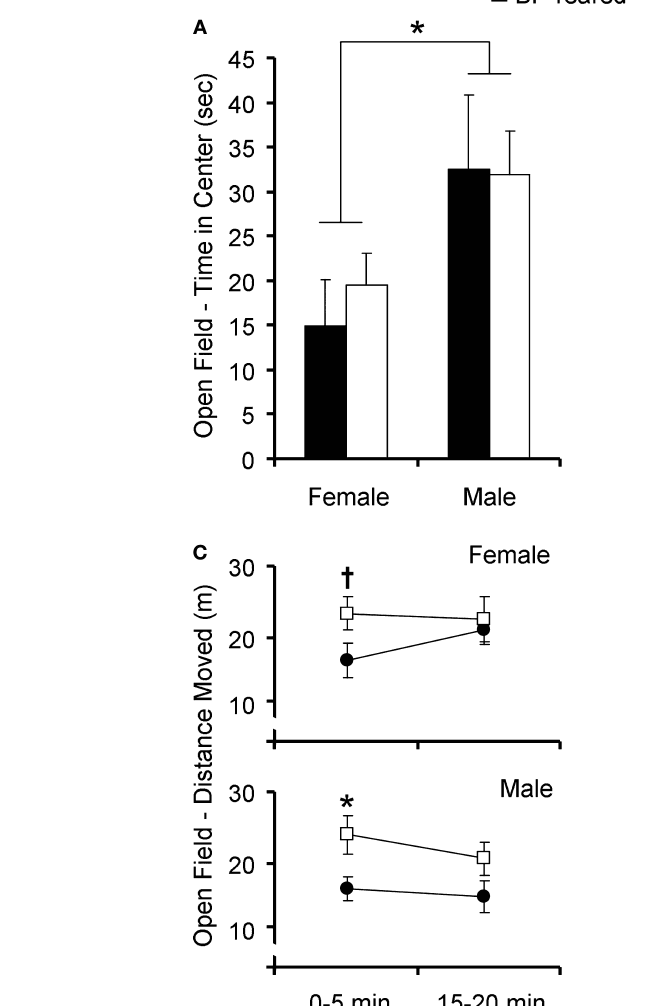
FIGURE 5 | Anxiety behavior and locomotor activity. SM- and BP-reared adults were tested for anxiety and exploratory/locomotor activity in the open-fi eld and elevated plus maze (EPM). SM- and BP-reared adult animals showed no differences in time spent exploring the anxiety-inducing center zone of the open-fi eld (A) , but SM-reared animals did spend a greater percentage of time in the anxiety-inducing open-arms of the EPM (B) ,